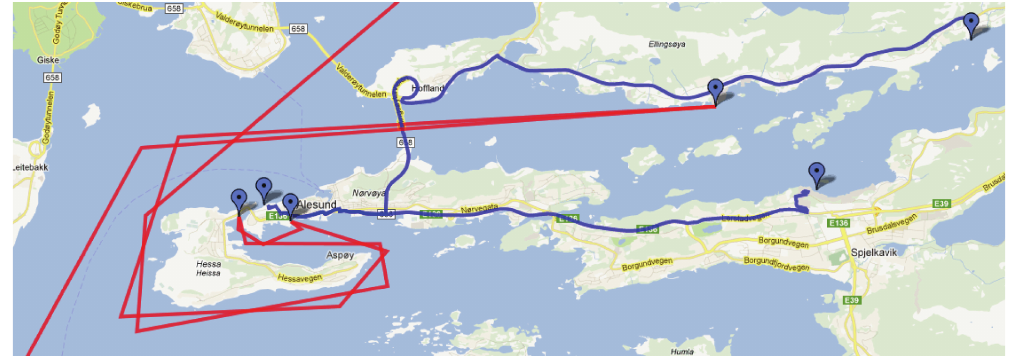
Figure 2: Local transportation in the ˚Alesund